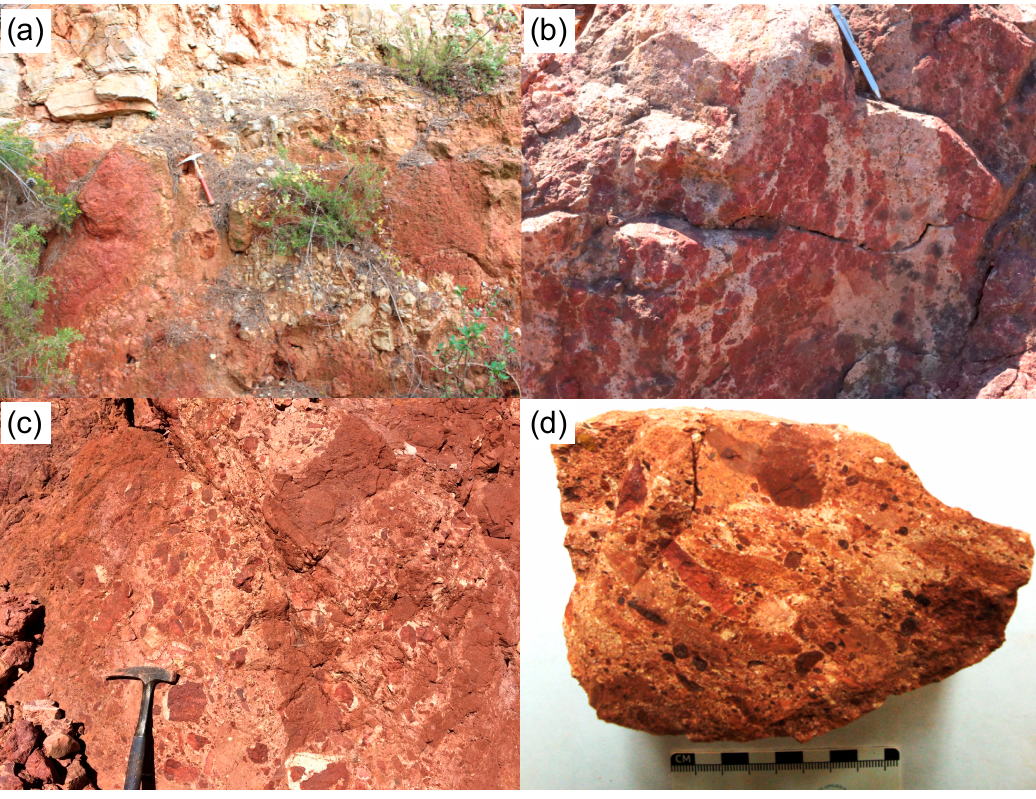
Figure 2. Outcrops and samples from localities included in this study: ( a ) Les Baux ‐ de ‐ Provence: top part of the bauxite profile, ( b ) Villeveyrac: bleached structure in the bauxite horizon, ( c ) Loupian: detrital features at the outcrop scale, ( d ) Loupian: sample LUP_A15. Table 1. ( a ) Locations, ( b ) mineralogy and ( c ) major, minor and trace element compositions of the studied bauxite samples.